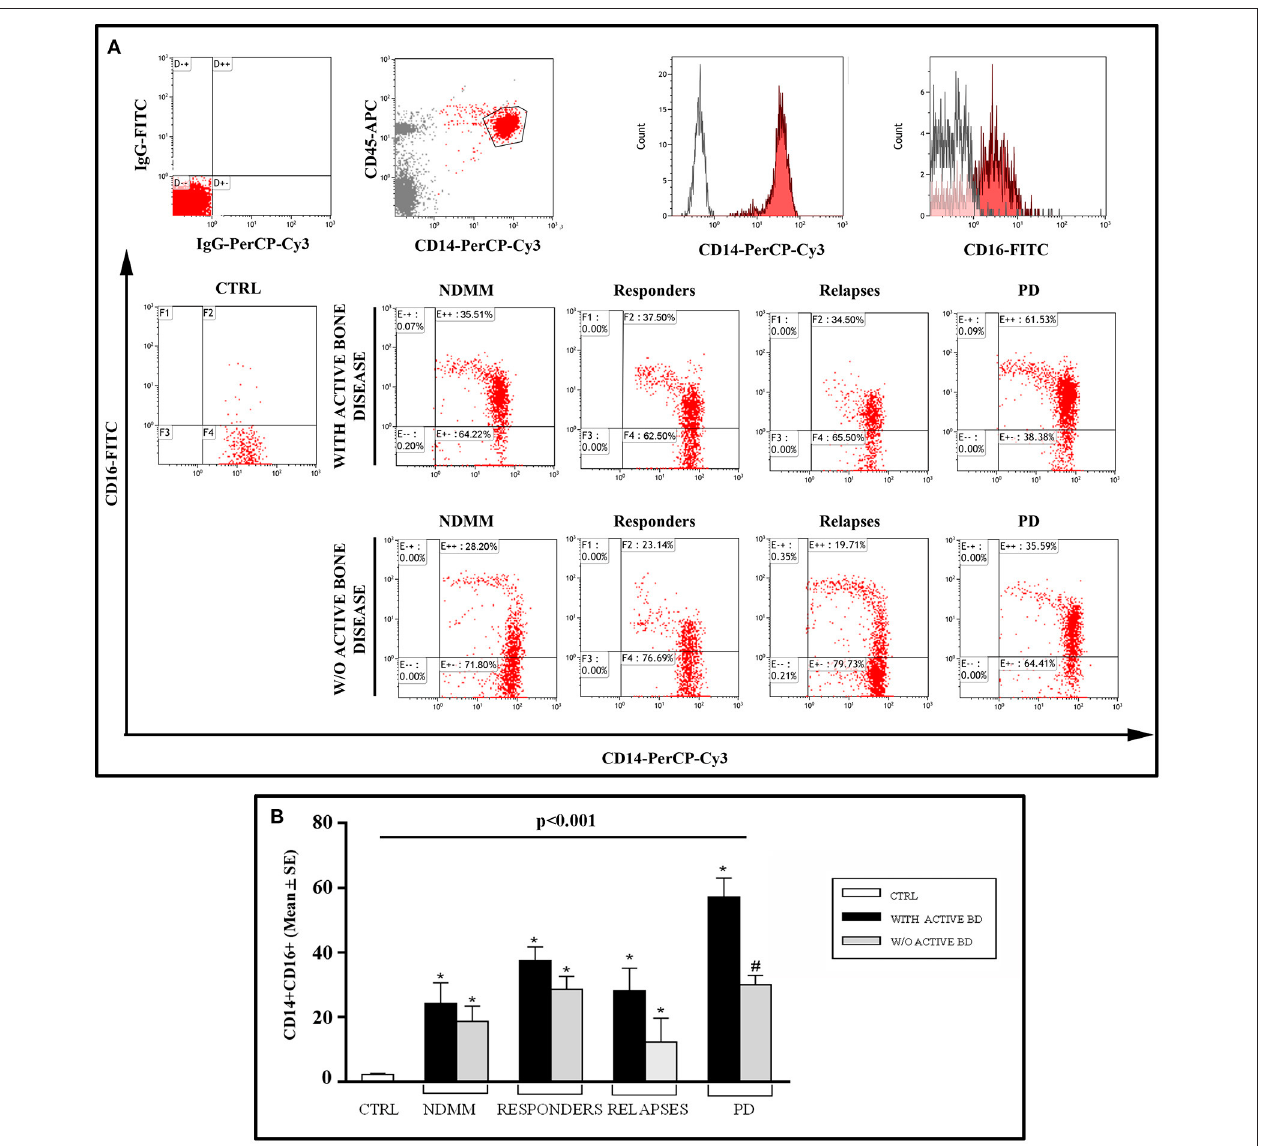
FIGURE 3 | CD14 + /CD16 + monocytes in MM patients and controls. (A) Flow cytometry graphs show IgG-FITC and IgG-PerCP-Cy3 isotype controls, CD14 + monocytes gated on CD45 + cells, single stain of a representative CD14 + and CD16 + cells; dot plots show CD14 + /CD16 + monocytes, from a representative control (CTRL) and representative patients with newly diagnosed multiple myeloma (NDMM), or responders, or at relapses or progressive disease (PD) without or with active bone disease (BD). (B) The histograms represent the mean values ± S.E. obtained from all the enrolled controls and patients. P < 0.001 for comparison of all groups (one-way ANOVA on ranks), and * P < 0.05 (Dunn’s post-hoc test) vs. CTRL, # P < 0.05 with active BD vs. w/o active